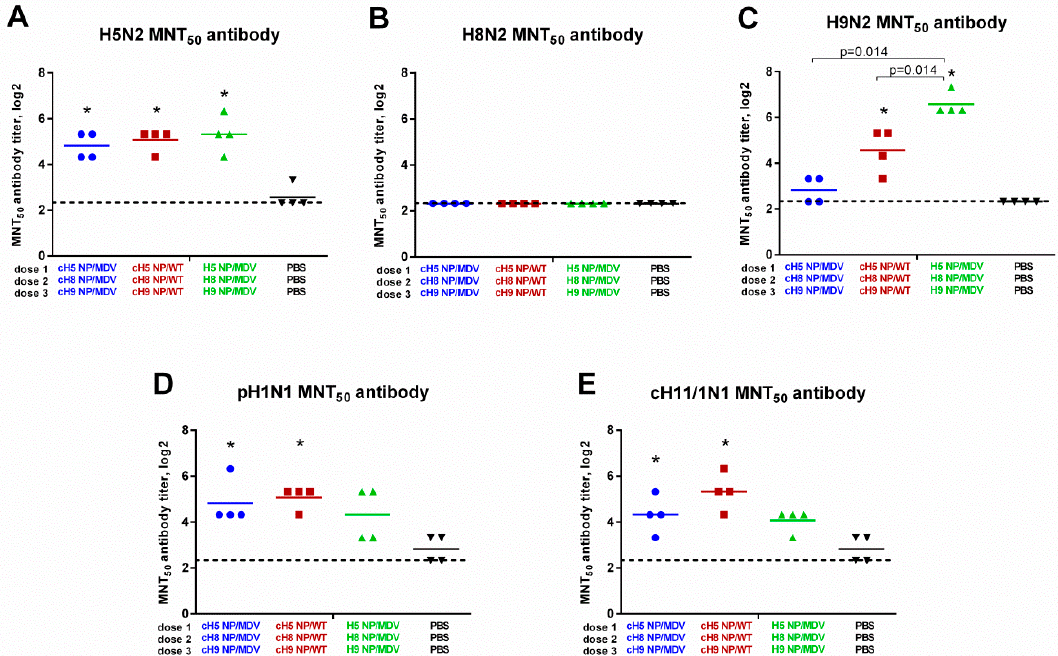
Figure 7. Neutralizing activity of the induced antibody responses. Broadly neutralizing antibody responses in immunized ferrets were measured in 50% microneutralization test (MNT 50 ) against: H5 NP/MDV LAIV virus ( A ); H8 NP/MDV LAIV ( B ); H9 NP/MDV LAIV ( C ); A/South Africa/3626/2013 (pH1N1) virus ( D ); and cH11/1N1 LAIV virus ( E ). * indicates significant difference with the mock-vaccinated group. The dashed line indicates the limit of detection.